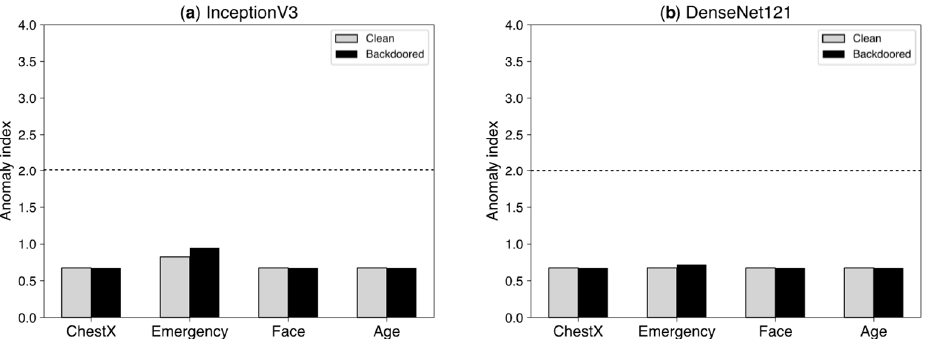
Figure 1. Anomaly index for the models fine-tuned from the backdoored and clean ImageNet models for pneumonia classification from chest X-ray images (ChestX), emergency response monitoring from aerial images (Emergency), face recognition (Face), and age classification from face images (Age): InceptionV3 ( a ) and DenseNet121 ( b ) architectures.